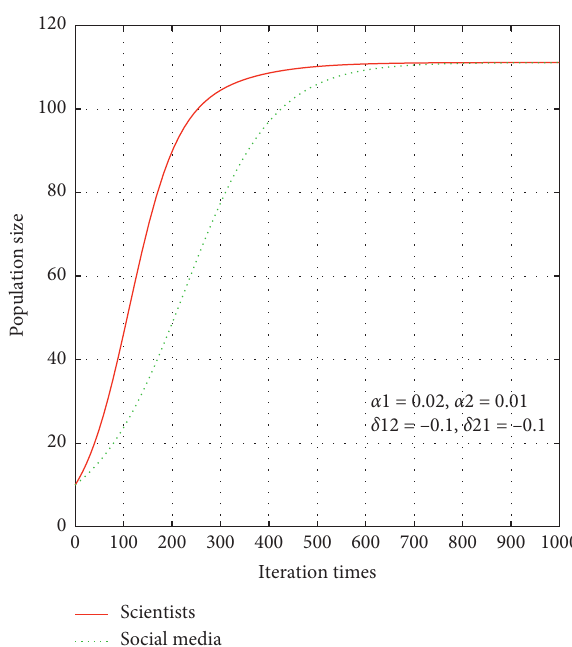
Figure 8: Symmetric mutualism pattern. Changes in the size of the two populations after 1000 iterations ( α � − 0 . 1, and δ � − 0 . δ 12 21